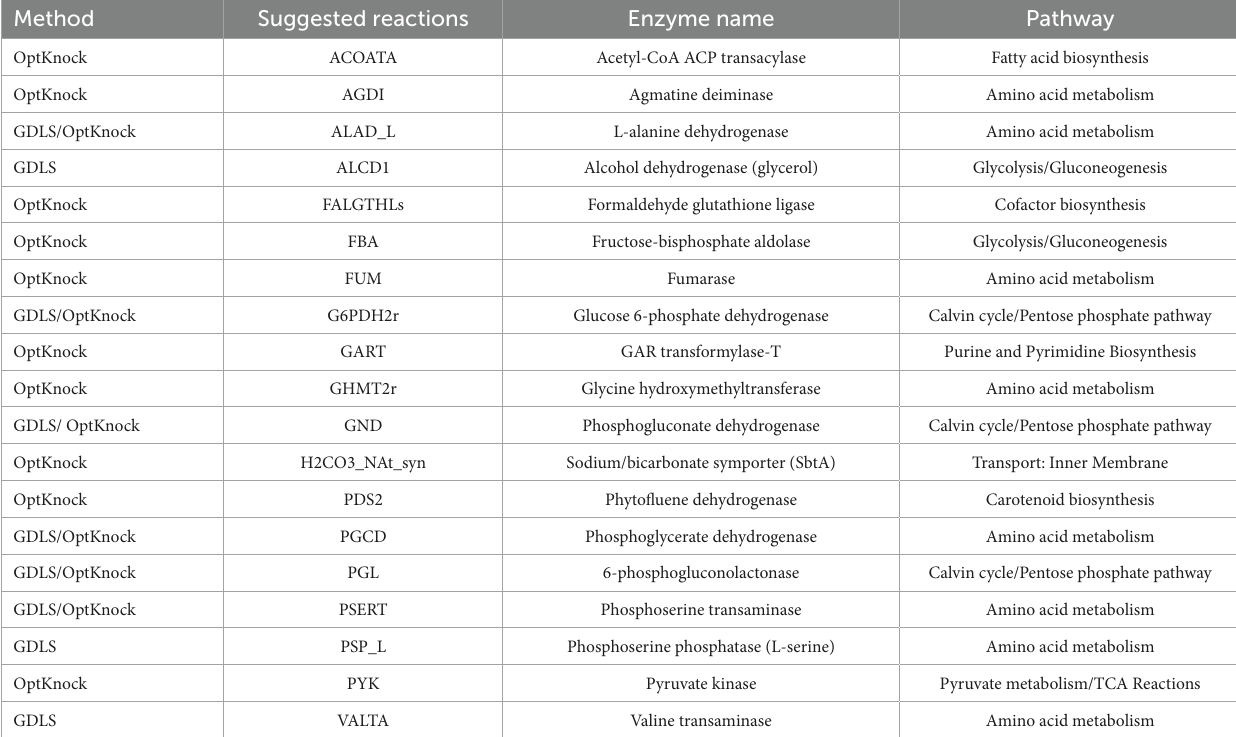
TABLE 2 Comparison of the reactions suggested by OptKnock and GDLS to be deleted in order to increase the production of ALA.